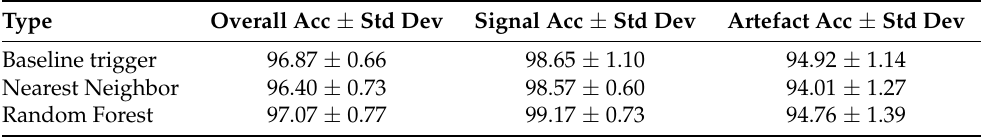
Table 3. Performance of the base model applied to the input data. Three variants of classifiers using manually selected two features were analysed: a simple heuristic model based on decision rules, a kNN type classifier (k = 7, metric = L2) and a classifier based on boosted decision trees called random forests (number_estimators = 100, depth_trees = 2). Results have been estimated using repeated k-fold validation (5 rounds with 5 folds each).